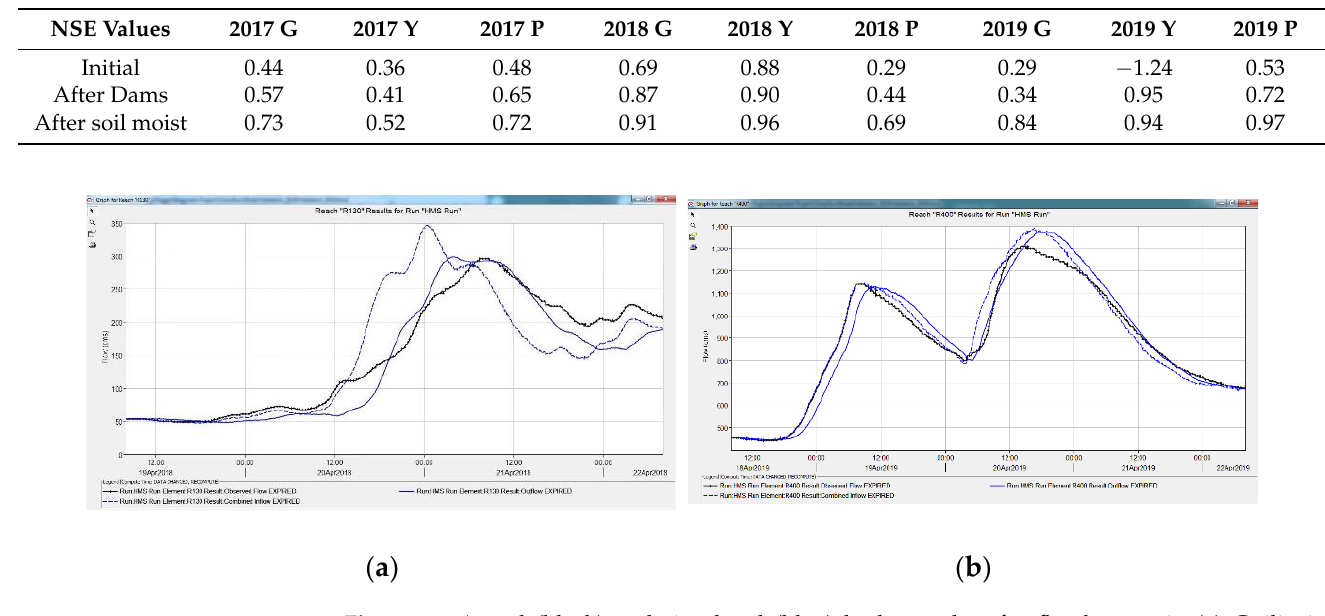
Figure 9. Actual (black) and simulated (blue) hydrographs of a flood event in ( a ) Guilin in 19 – 22 April 2018 and ( b ) Yangshuo station in 18 – 22 April 2019 after LSTM modifications with ARCK and